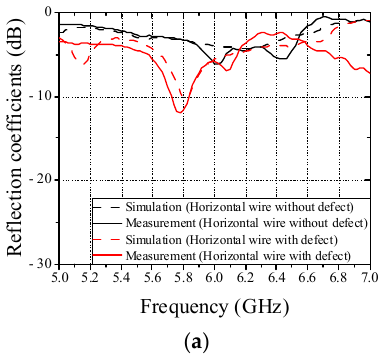
Figure 5. Full-wave simulated and measured reflection coefficients of patch antenna in cases of wires without and with defect. ( a ) Horizontal wire. ( b ) Vertical wire.